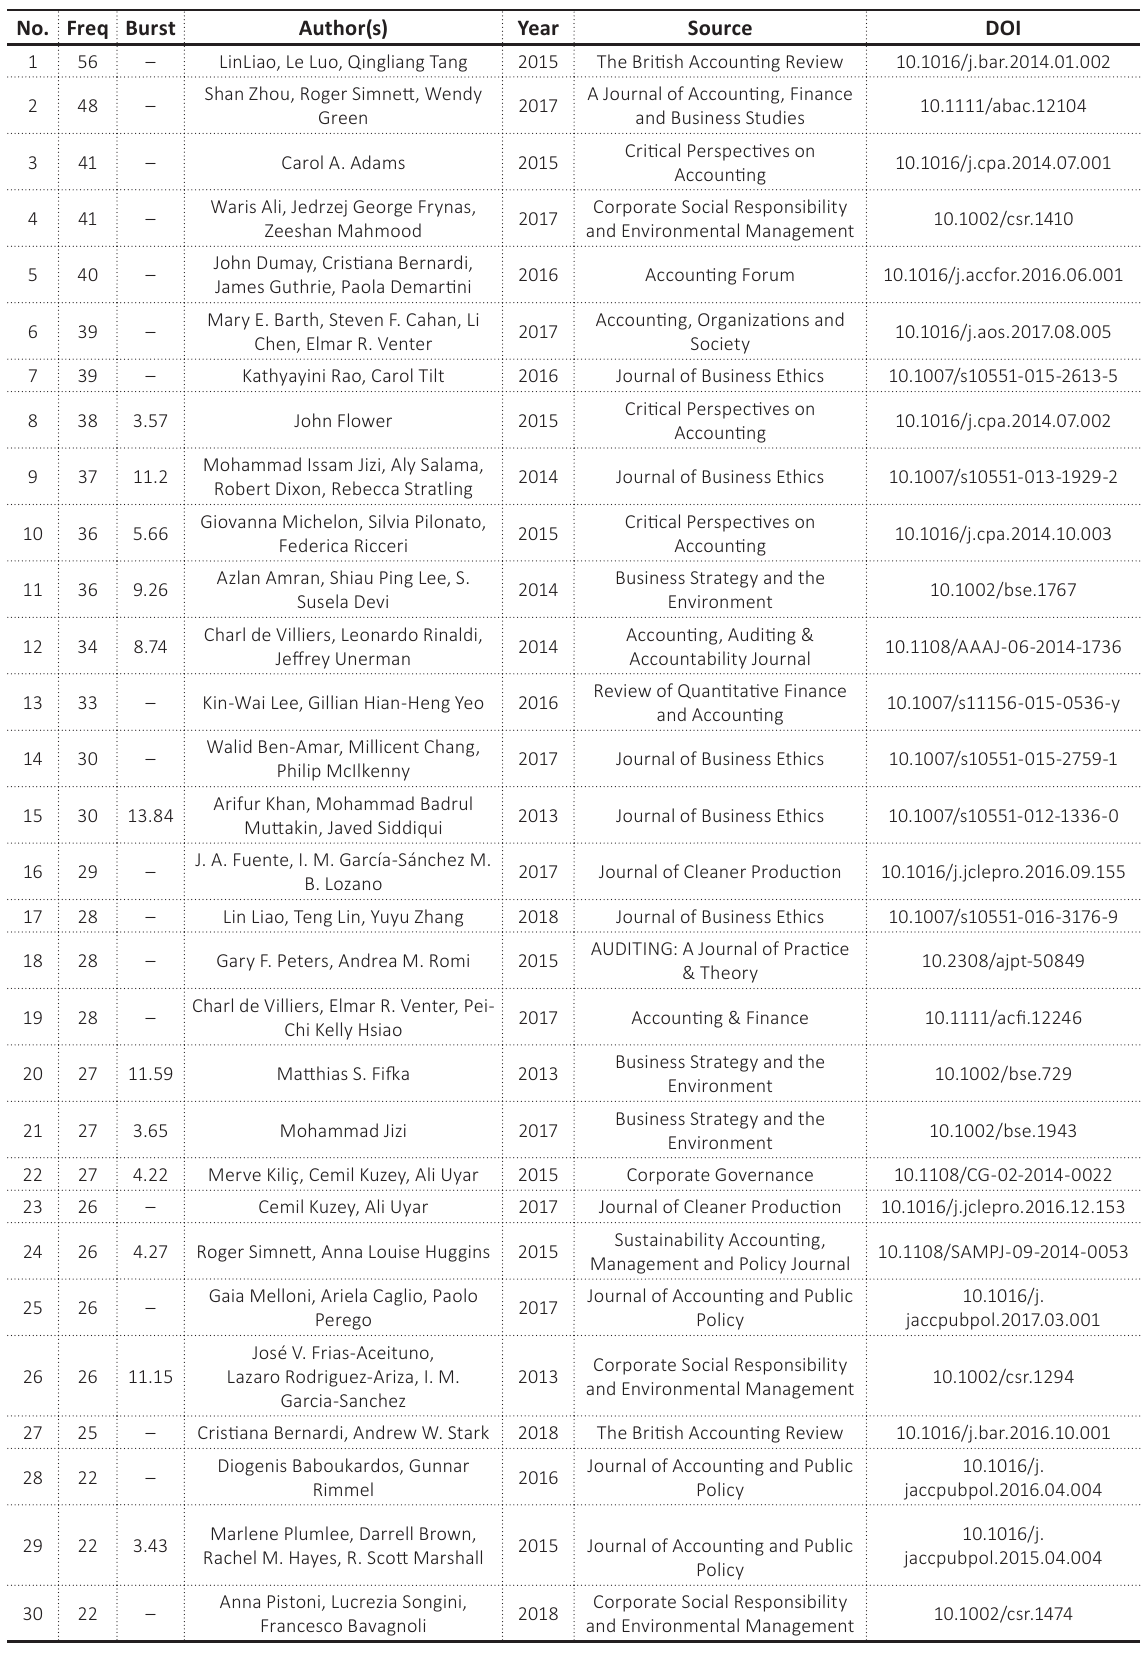
Table 6. Statistics of the number of references cited No. Freq